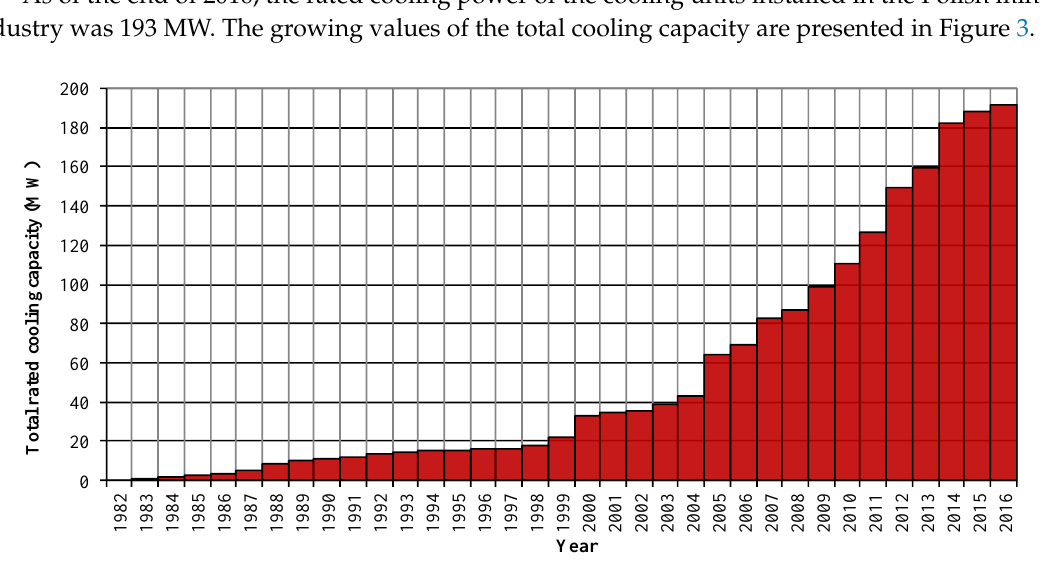
Figure 3. The changing values of the total cooling power in Polish mines.